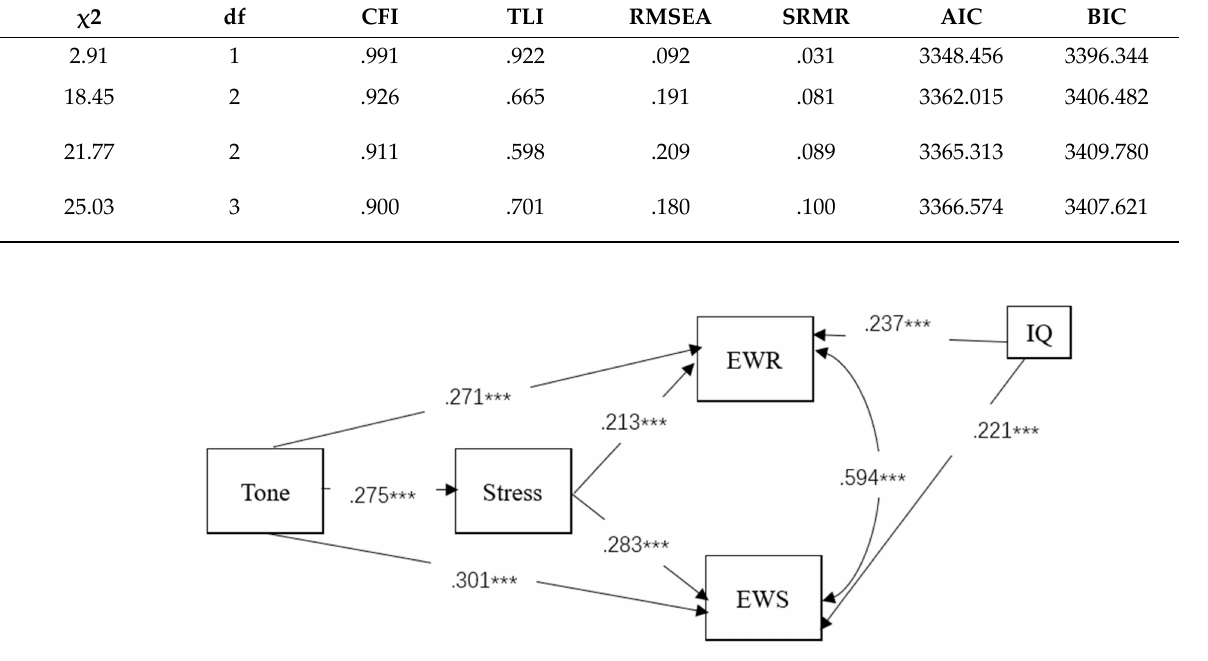
Figure 2. Standardized factor loadings on the path routes between tone and English word‑level literacy (the best‑fitting model). *** p <